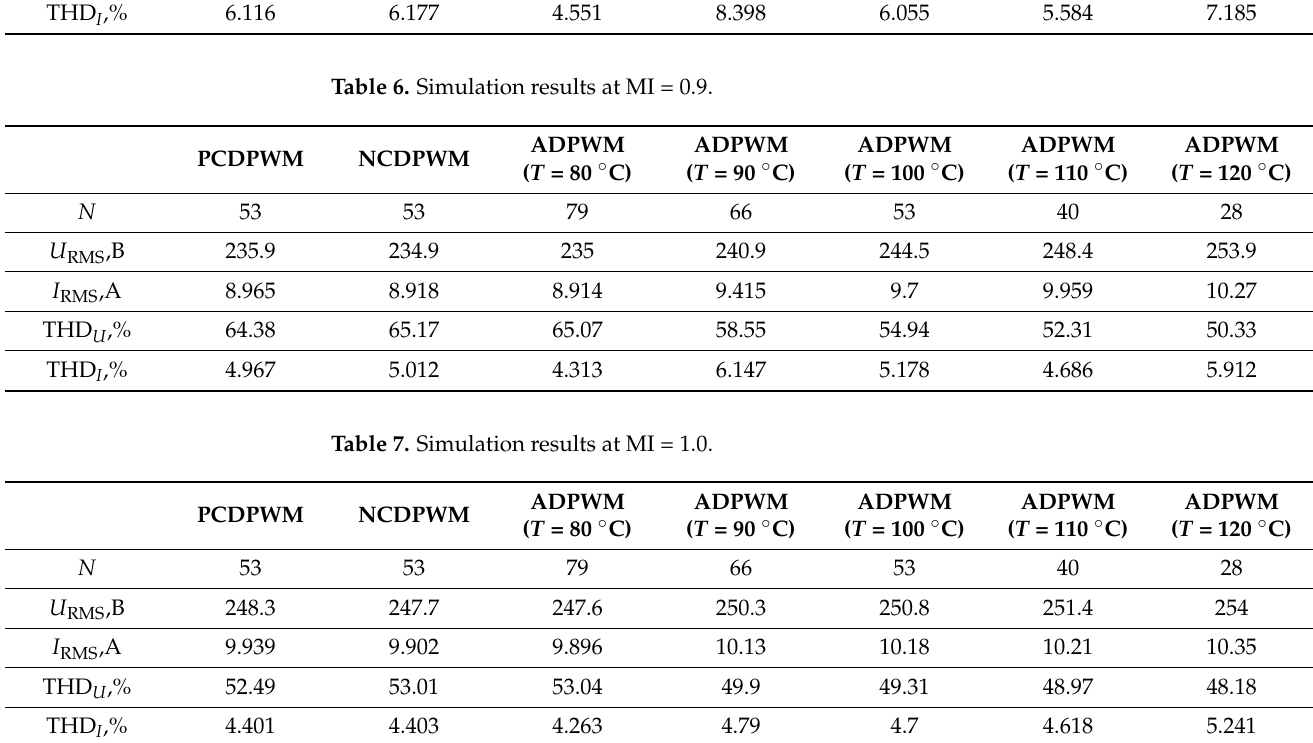
Table 6. Simulation results at MI = 0.9.